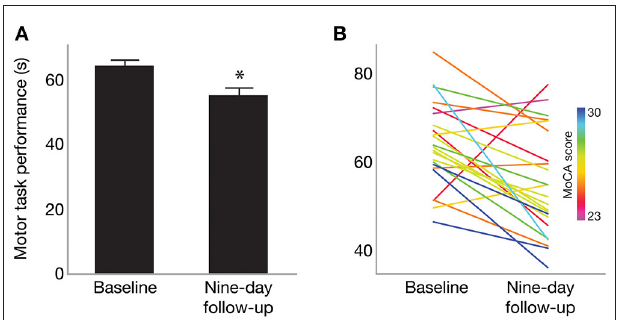
FIGURE 2 | (A) Mean motor task performance at baseline and 9-day follow-up. On average, trial time (in seconds) was significantly faster at nine-day follow-up compared to baseline. *Indicates p = 0.0016. (B) Motor performance for each participant at baseline and 9-day follow-up. Line color indicates each participant’s MoCA score, with warmer colors indicating lower MoCA scores and cooler colors indicating higher MoCA scores (range